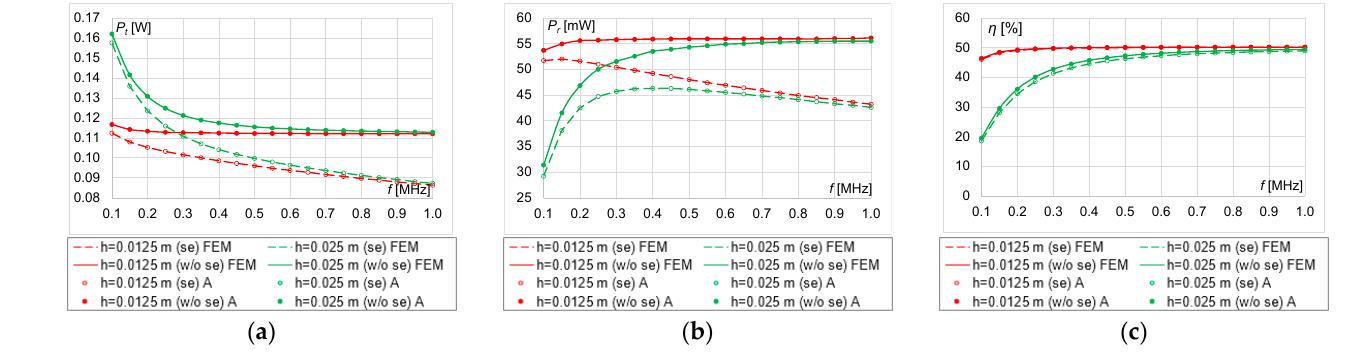
Figure 23. Results for n = 70 for the cases with and without skin effect: ( a ) P t , ( b ) P r , ( c ) η .